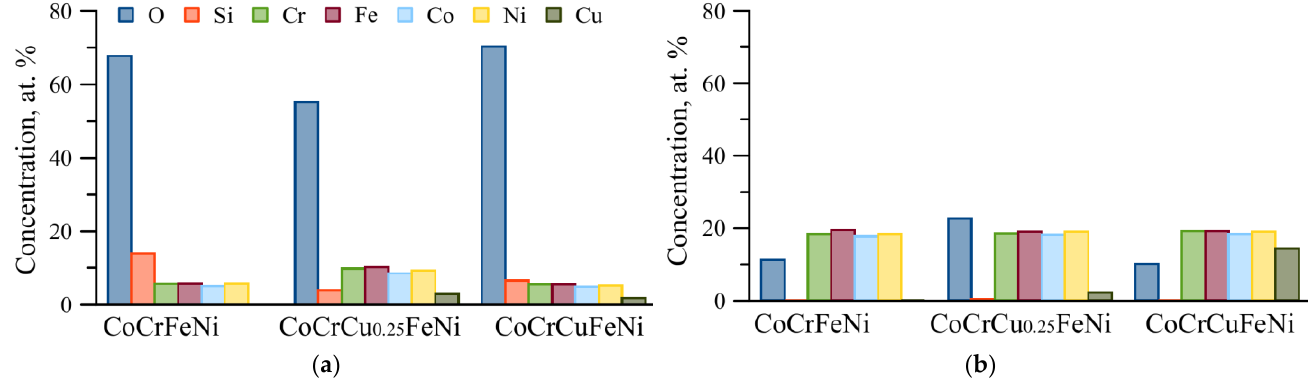
Figure 8. Concentration of elements in the areas where oxidative ( a ) and abrasive wear ( b ) predominate.